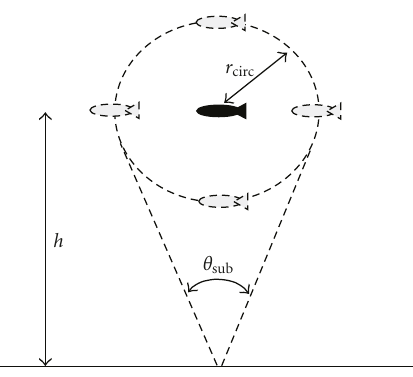
Figure 4: StratXX platform position keeping